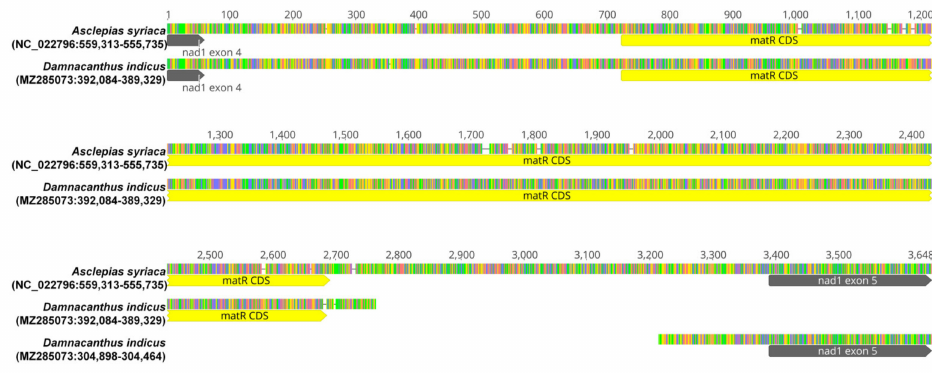
Figure 5. Alignment of the mitochondrial regions of nad1 exon4, exon5, matR , nad1i728 in Asclepias syriaca and Damnacanthus indicus . Horizontal lines with four kinds of colors are nucleotides (red = A, green = T, yellow = G, blue = C). Black lines between nucleotides represent gaps in the alignment. Below the sequences, the annotations for regions of exons and CDS are presented as dark gray and yellow arrows, respectively. The regions for nad1i728 include matR and sequences without